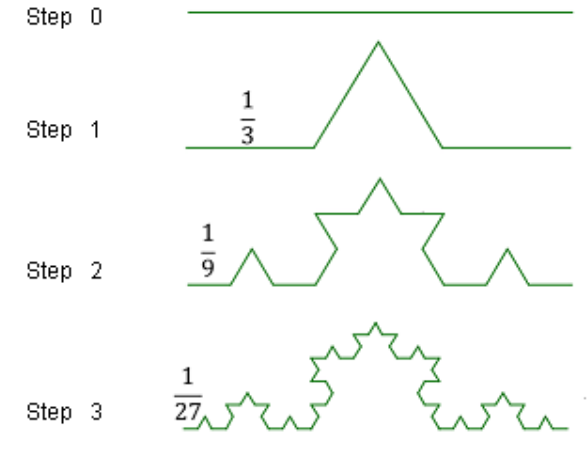
Figure 1: The first four iterations of the Koch fractal